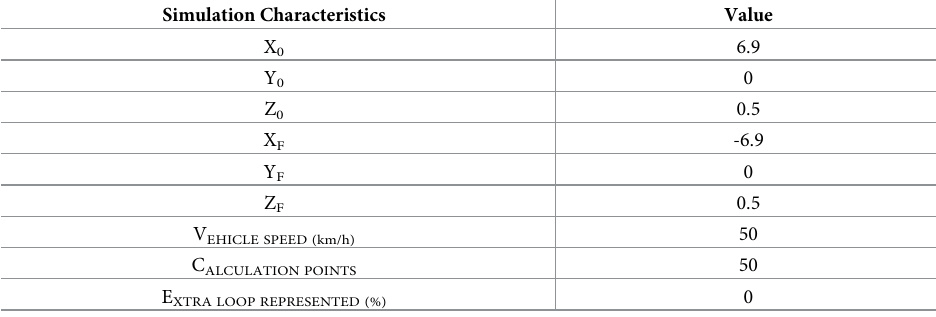
Table 9. Bus simulation